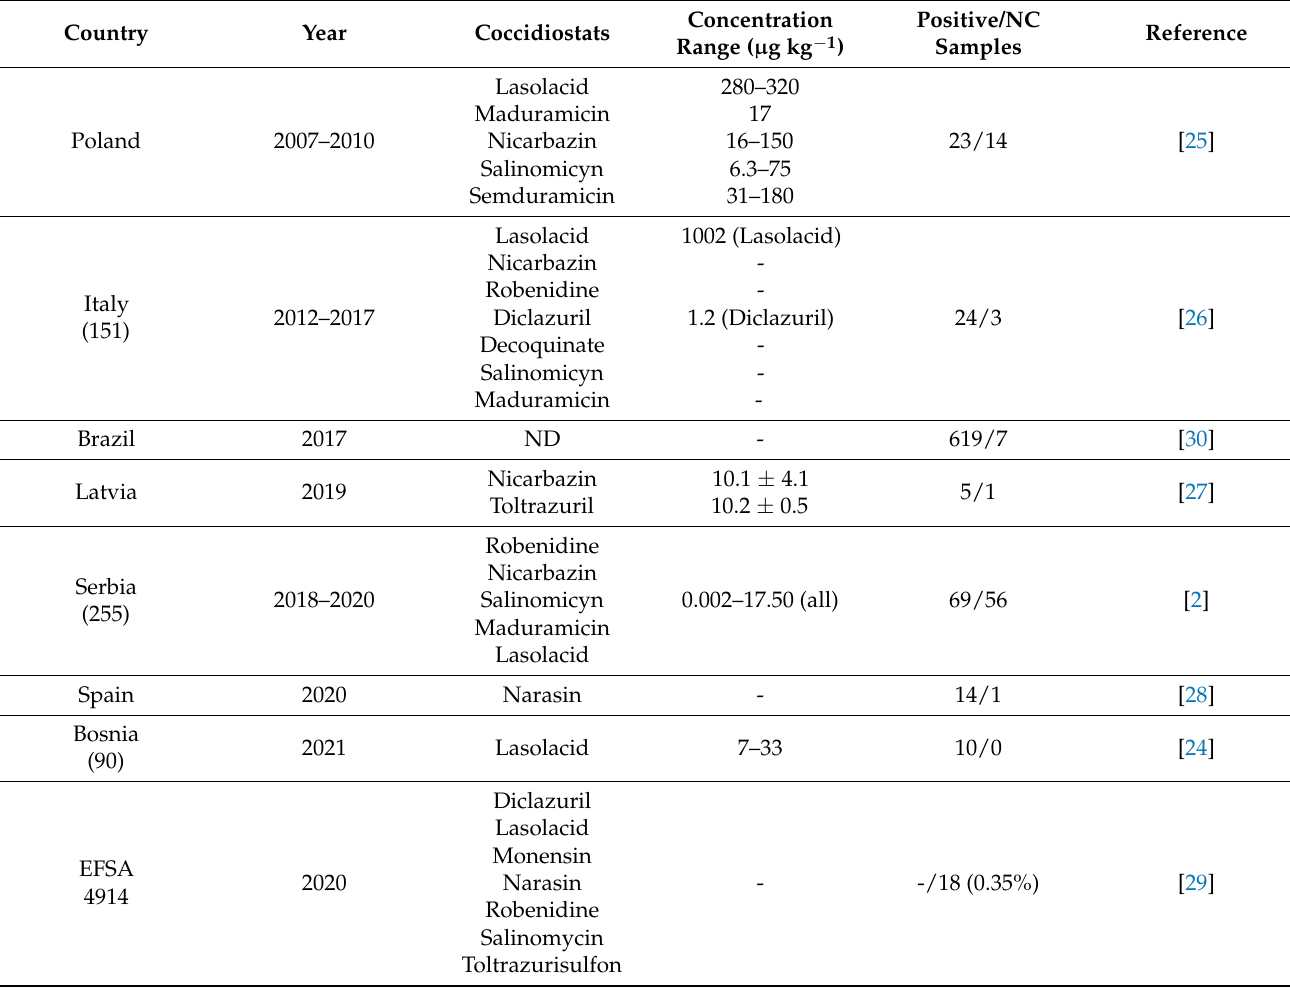
Table 4. Coccidiostats reported in recent studies worldwide.